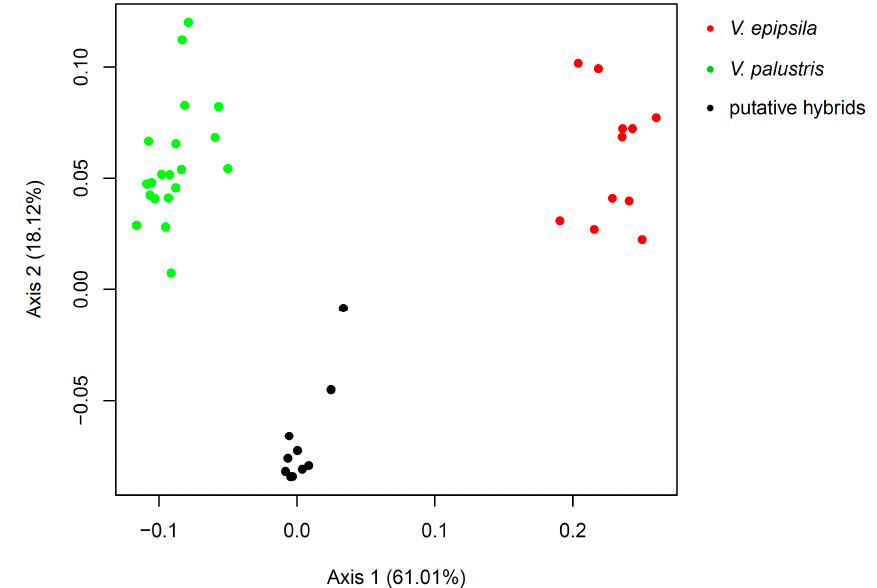
Figure 5. Results of principal coordinate analysis (PCoA) based on Dice coefficient.